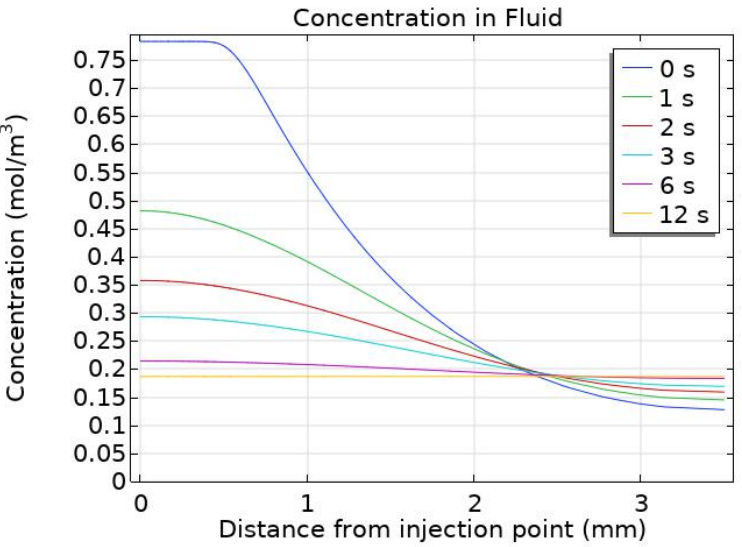
Figure 7. Particle concentration within the fluid during the first 10 s post-injection along the distance from the point of injection.